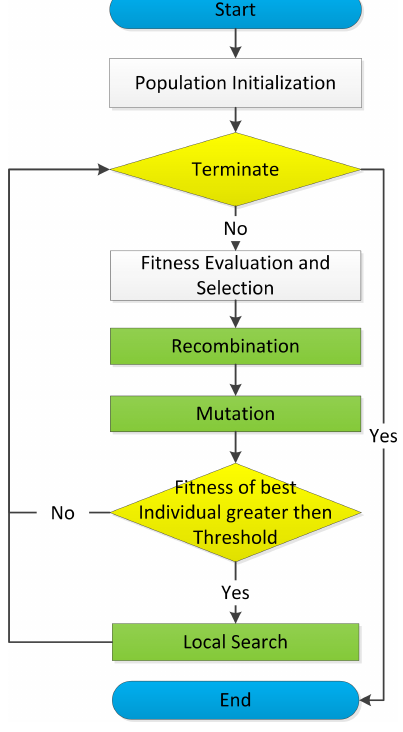
Figure 1. Algorithm description